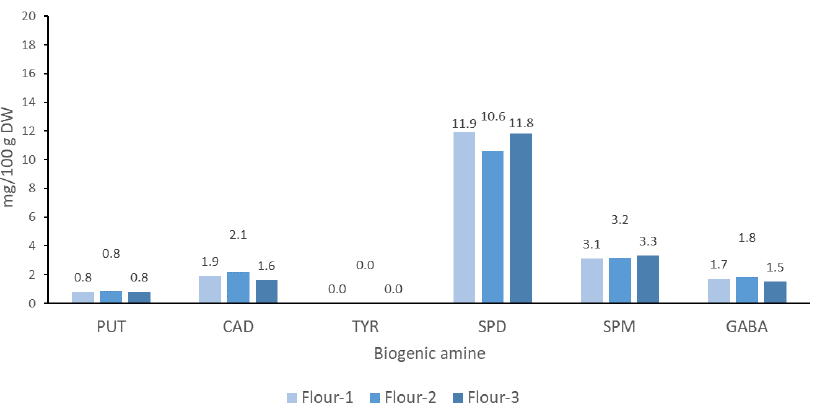
Figure A1. Putrescine (PUT), cadaverine (CAD), tyramine (TYR), spermidine (SPD), spermine (SPM) and gamma-aminobutyric acid (GABA) in chickpea flours: Flour-1; Flour-2, Flour-3.